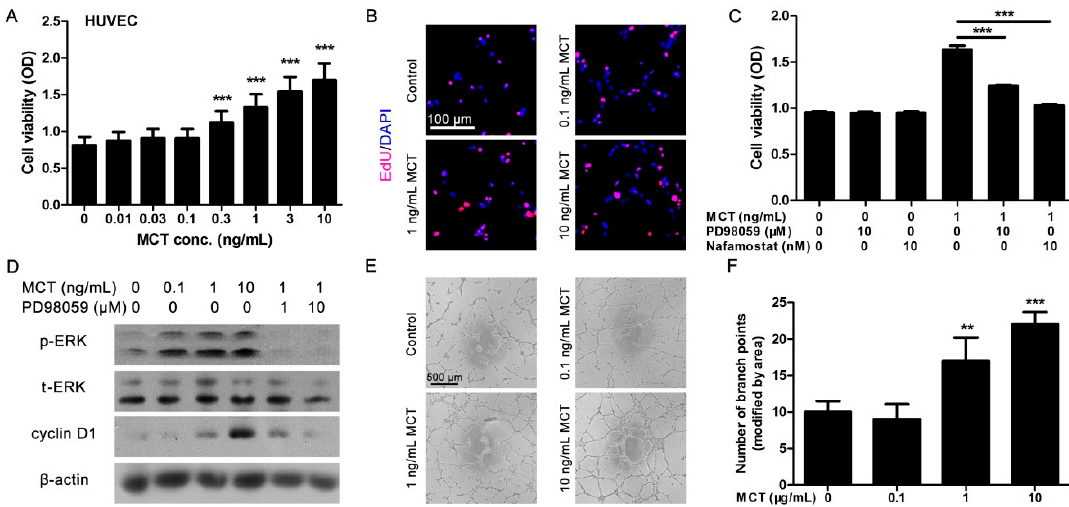
Figure 2. MCT promotes HUVEC proliferation and tube formation. ( A ) After HUVEC were treated with different doses of MCT for 24 h, CCK8 assays were used to determine the cell viability, *** p < 0.001, n = 6; ( B ) After HUVEC were treated with different doses of MCT for 24 h, EdU assays were used to determine cell proliferation. Red fluorescence indicate EdU-positive cells, DAPI dye stained all nuclei. Scale bar = 100 µ m and refer to all panels; ( C ) After HUVEC were treated with MCT and/or PD98095 or nafamostat for 24 h, cell viability was measured by CCK8 assay. *** p < 0.001, n = 6; ( D ) After HUVEC were treated with MCT and/or PD98095 for 24 h, the cells were lysed and Western blot assays were used to detect the protein levels of pERK-, ERK-, and cyclin D1–treated HUVEC. The β -actin was internal reference, all blots were repeated for at least three times; ( E ) Tube formation assays were performed in HUVEC cells in the presence of different concentration of MCT. Scale bar = 100 µ m and refer to all panels; ( F ) The number of branch points in tube formation was analyzed, 15 random images in each group were selected for analysis, ** p < 0.01, *** p < 0.001. All statistical difference were analyzed by ANOVA and Student-Newman-Keuls tests.